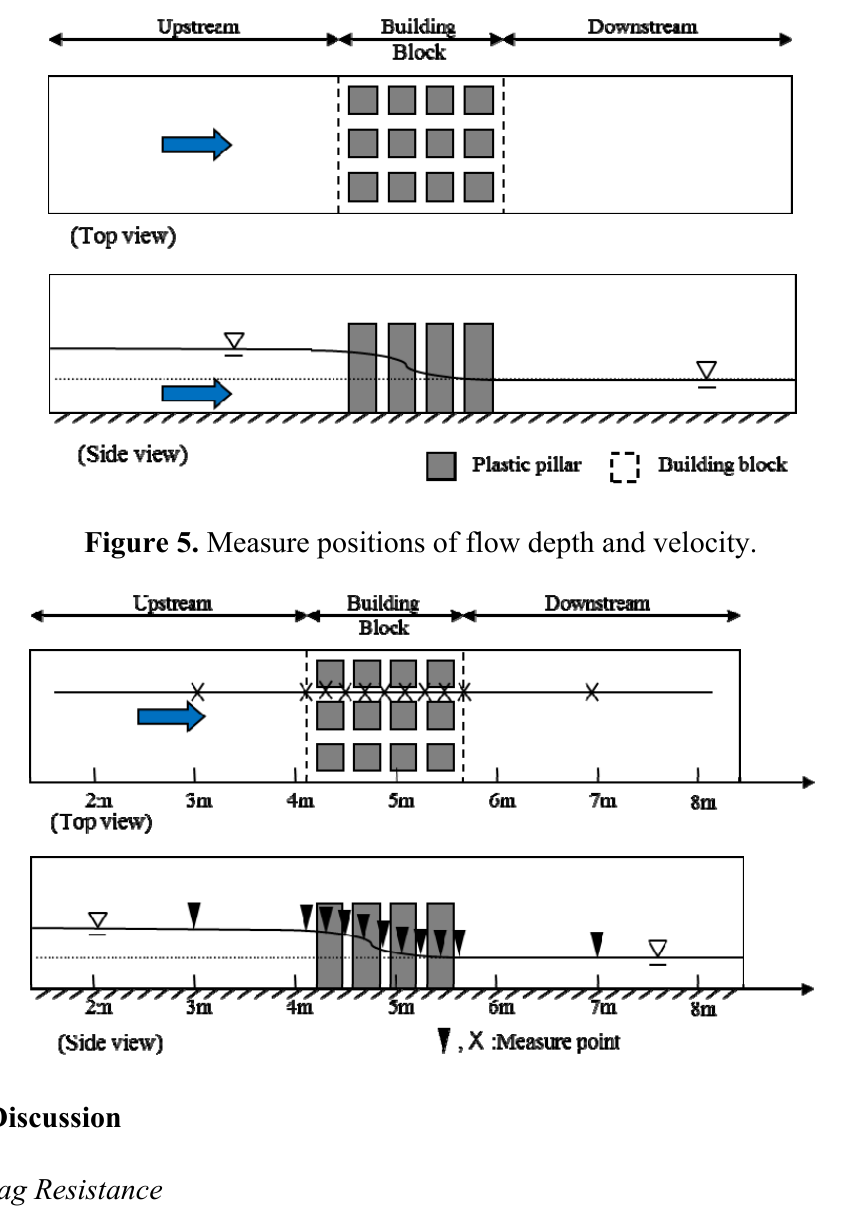
Figure 4. Settlement of experiment.